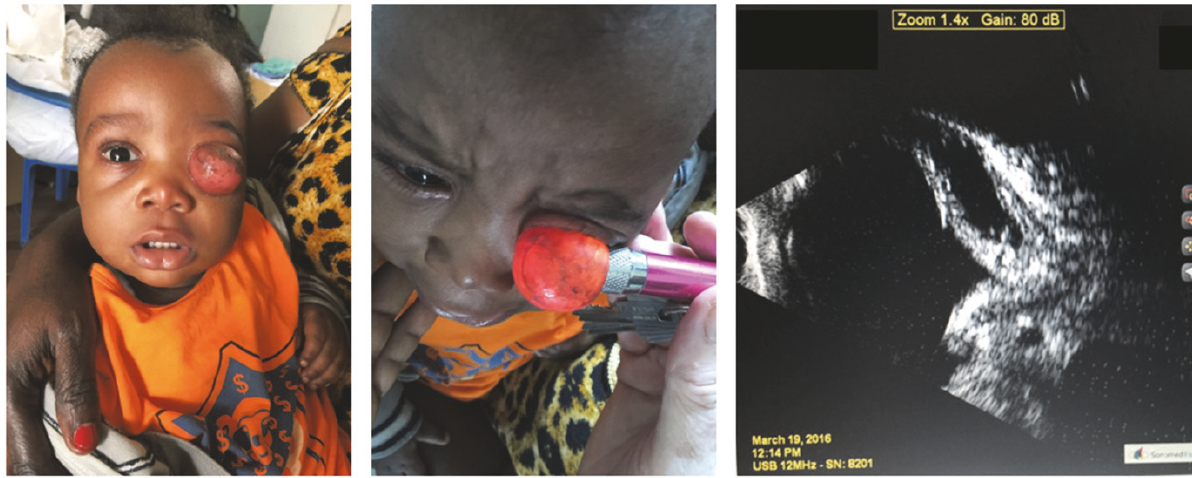
Figure 1: Patient with a clinical anophthalmos with orbital mass in the left orbit. A: protruded cyst. B: transillumination with a pen light revealed the cystic character of the structure. C: B-scan ultrasonography